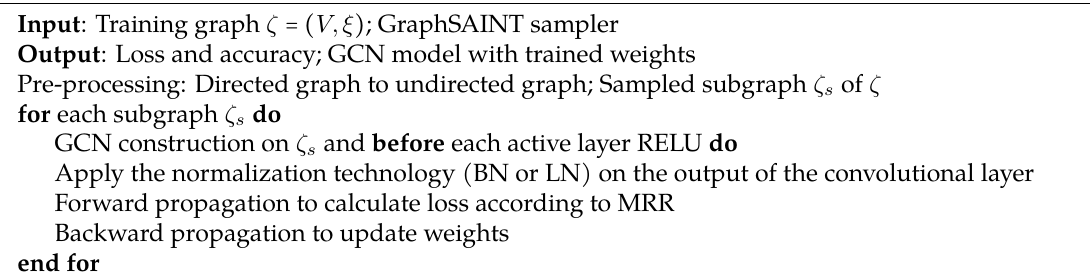
Algorithm 1 The improved GraphSAINT during training with the normalization technique (BN or LN) on the citation dataset of